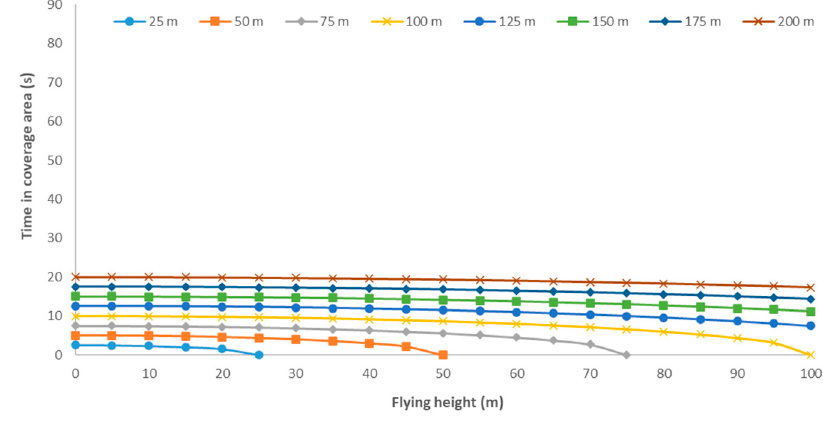
/ s and di ff erent dc